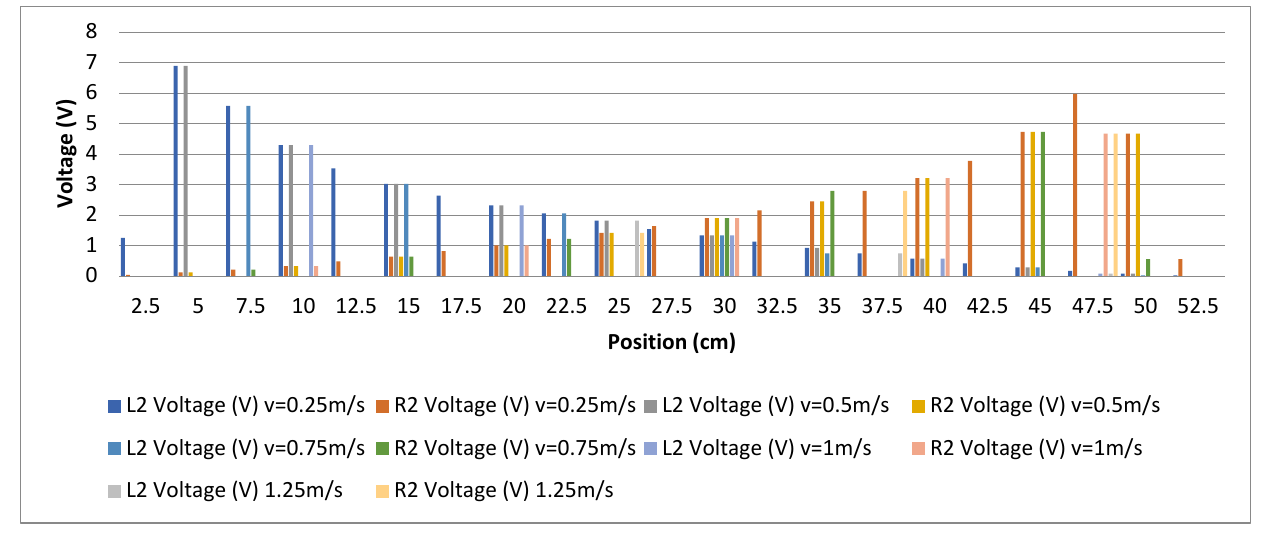
Figure 11. L2 and R2 voltage readings in terms of load contact points for different load speeds. Table 3. Example of full data provided by the six sensors for different load speeds for possible speed prediction/classification.